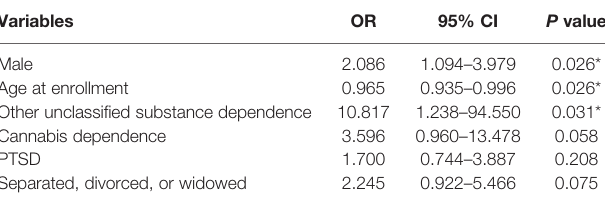
TABLE 3 | Multivariate logistic regression analysis of potential risk factors for bipolar patients with alcohol use disorder (AUD). Variables OR 95% CI P